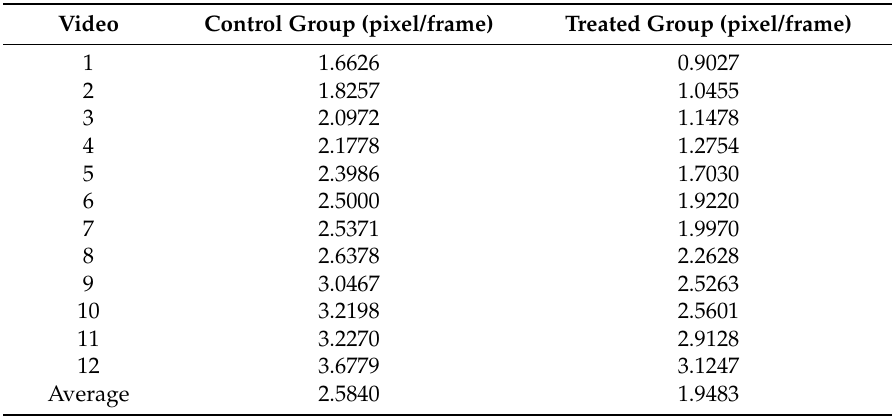
Table 3. Average velocities of fish of the treated group and the control